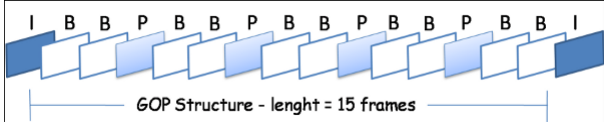
Figure 13. Typical strucure of group of packets (GoP)